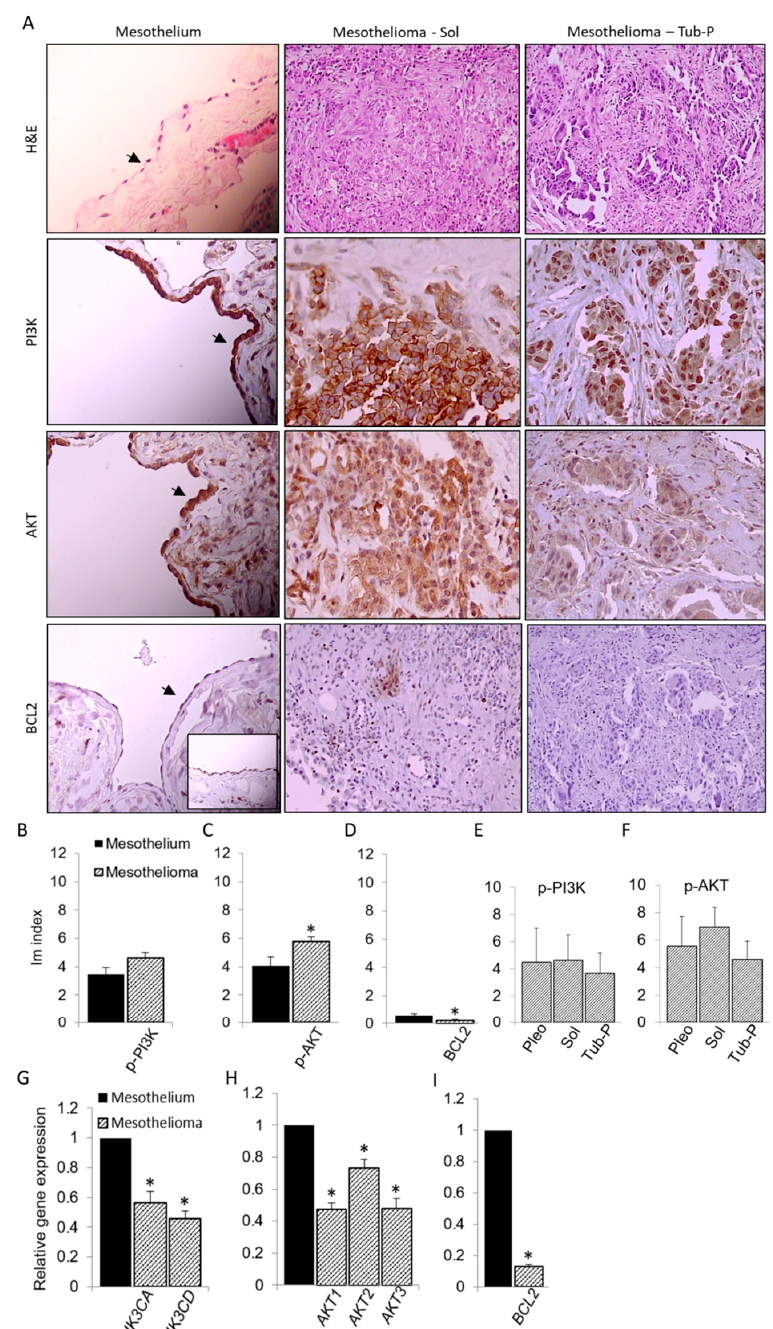
Figure 2. Expression of p-PI3K, p-AKT and BCL2 in mesothelioma. ( A ) Images represent samples of human normal mesothelium and two histological subtypes of mesothelioma, solid (Sol) and tubulopapillary (Tub-P) analyzed by H&E and immunohistochemical staining. All p-PI3K, p-AKT and mesothelium images are magnified × 400 and arrow marks monolayer of mesothelial cells. Other images are magnified × 200. A smaller mesothelioma BCL2 image shows sample with very high expression of BCL2, which is found only in few samples. ( B – D ) Summary data of Im index for each protein, representing relative expression of that protein in mesothelium and all mesothelioma samples. ( E , F ) Comparison of Im index among three subtypes of mesothelioma, pleomorphic (Pleo), Sol and Tub-P. Relative expression of two PI3K ( PIK3CA and PIK3CD ), three AKT ( AKT1 , AKT2 and AKT3 ) and BCL2 gene is summarized in ( G – I ). Data are means ± SEM; * p < 0.05 vs